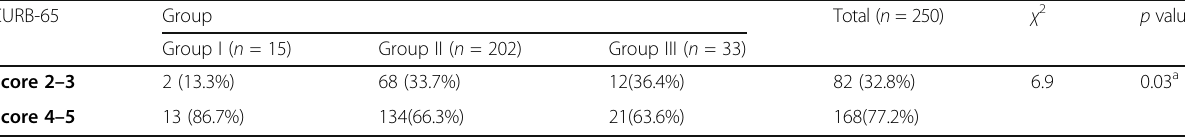
Table 3 CURB-65 score on admission among all studied groups CURB-65